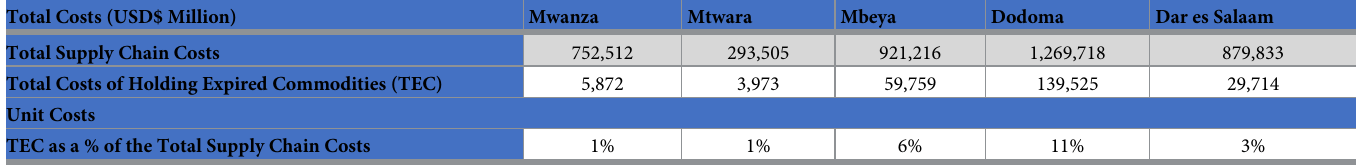
Table 6. Average costs of holding expired commodities at the medical stores department, (2020 US$). Total Costs (USD$